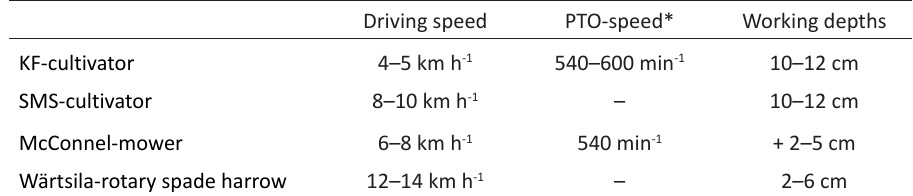
Table 4. Machinery adjustments in experiment